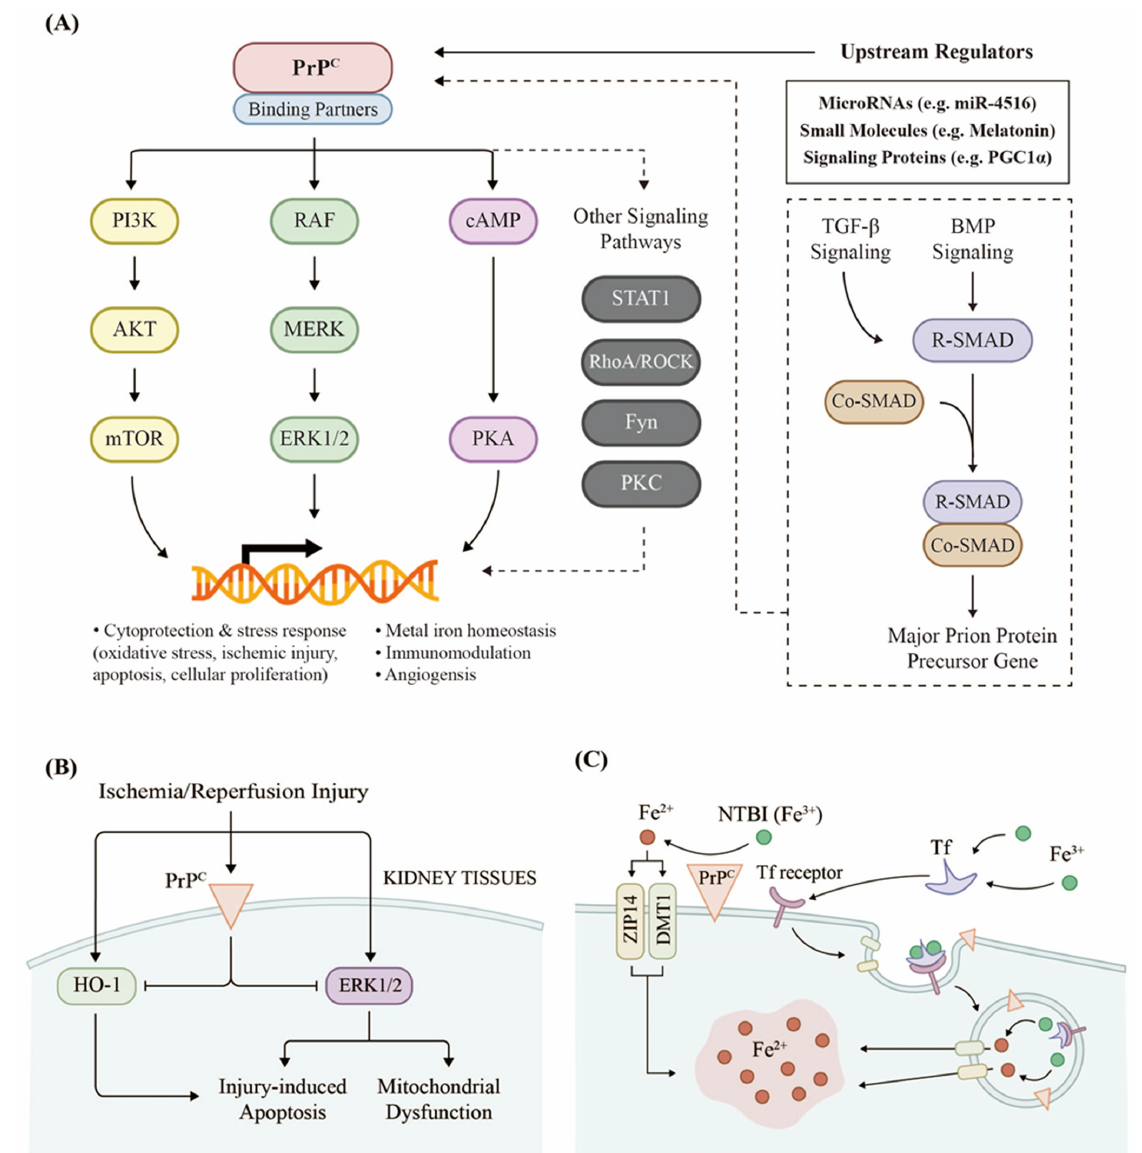
Figure 2. Endogenous PrP C in the kidneys plays a role in cellular signaling processes to influence renal physiology. ( A ) PrP C mediates a variety of downstream signaling pathways via interactions with appropriate binding partners in kidney tissues. There are numerous PrP C -signaling pathways that are characterized in neuronal cells, and some of these have been cross-validated in the kidney, while others have not. The signaling proteins and interaction mechanisms that merit further validation in renal models are shown in grayscale or dotted lines. ( B ) PrP C has been associated with some protective functions against ischemic injury through affecting the ERK1/2 transduction pathway and heme oxygenase-1 (HO-1). ( C ) PrP C exhibits ferrireductase activity to promote the uptake of transferrin- (Tf) and non-Tf-bound iron (NTBI) by the kidneys. Fe 3+ ions are bound to transferrin, which can enter proximal tubular cells. PrP C ferrireductase activity produces Fe 2+ , which can be released into the cytoplasm through DMT1 and ZIP14.